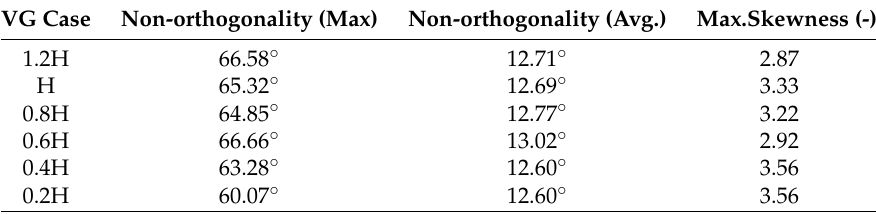
Table 1. Quality meshing parameters for each analyzed vortex generators (VG)